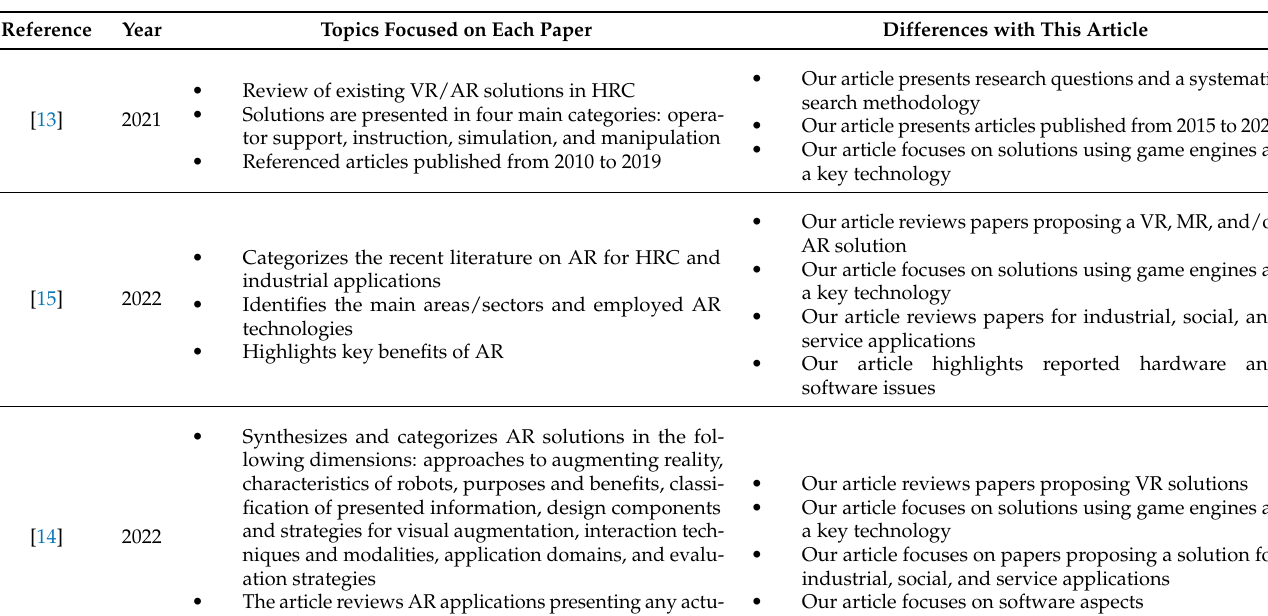
Table 1. Differences between this article and similar works recently presented in the robotics